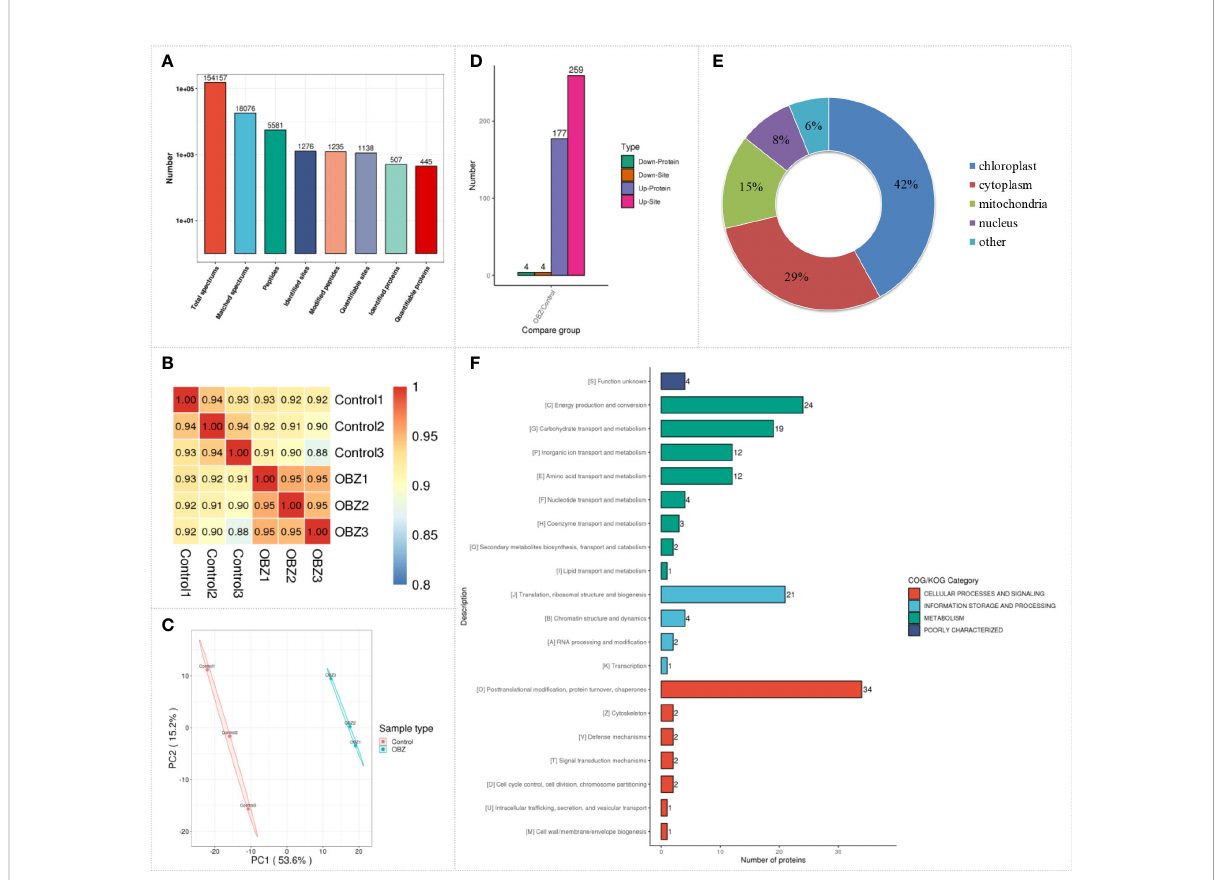
FIGURE 2 Characterization of lysine succinylation under OBZ treatment in pakchoi leaves. The number of identi fi ed proteins and sites containing the indicated lysine succinylation (A) , PCC analysis (B) , PCA analysis (C) , differentially expressed succinylation proteins and sites (D) , subcellular classify (E) , and KOG classi fi es (F)